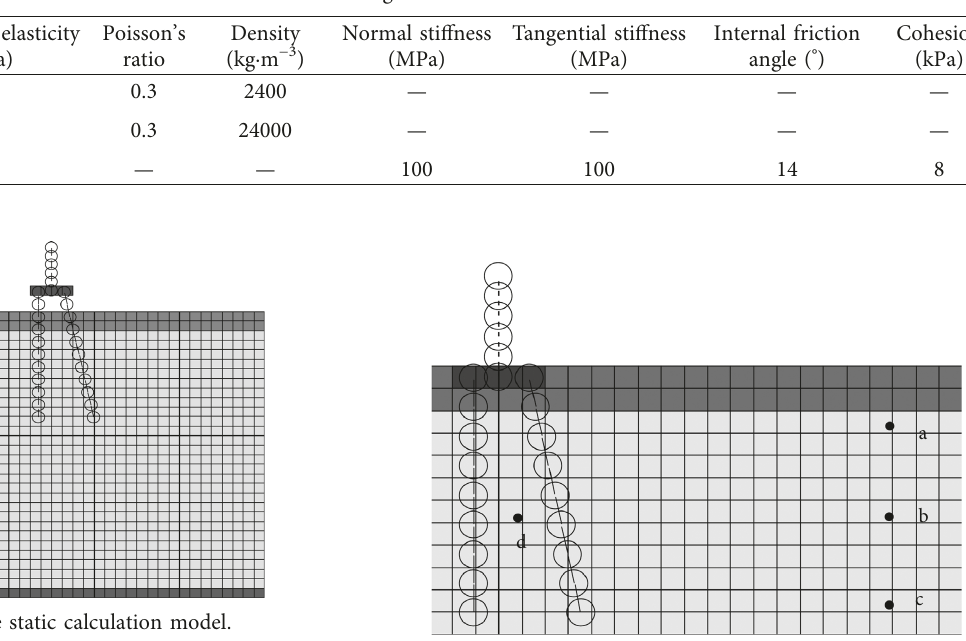
Table 3: Parameters of the bridge structure and the interface.